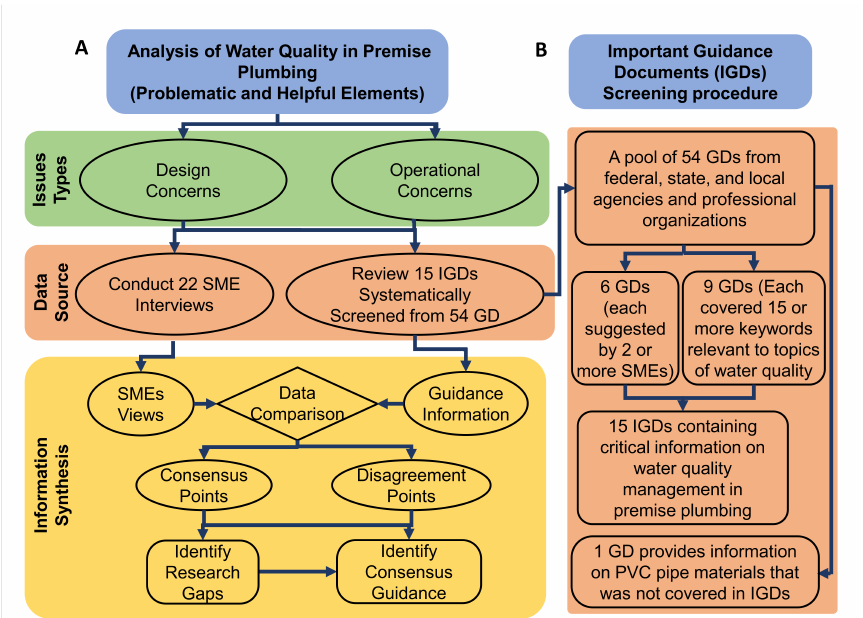
Figure 1. ( A ) Schematic showing the process of data collection and analysis for water quality management in premise plumbing. ( B ) Flow chart showing screening the important